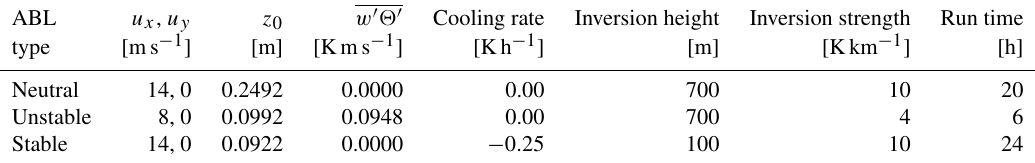
Table 1. Initial forcing, configuration parameters, and total simulation time for the three types of simulated flows.